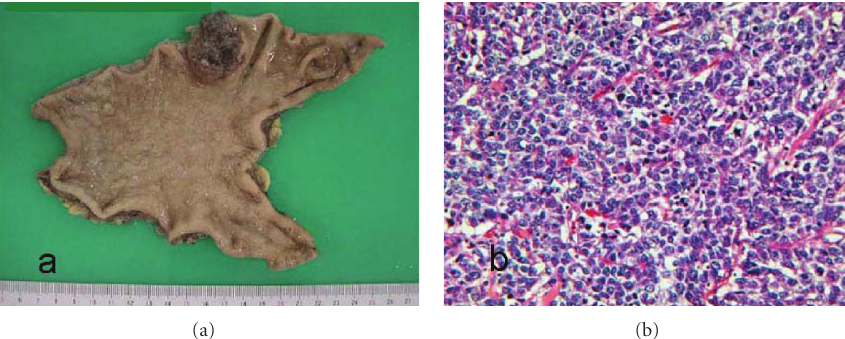
Figure 1: Resected specimen and pathological findings. (a) Macroscopic appearance of surgically resected specimen showing type 2 advanced gastric cancer in the corpus of the stomach. (b) Pathological examination showing a poorly di ff erentiated adenocarcinoma (H&E stain).